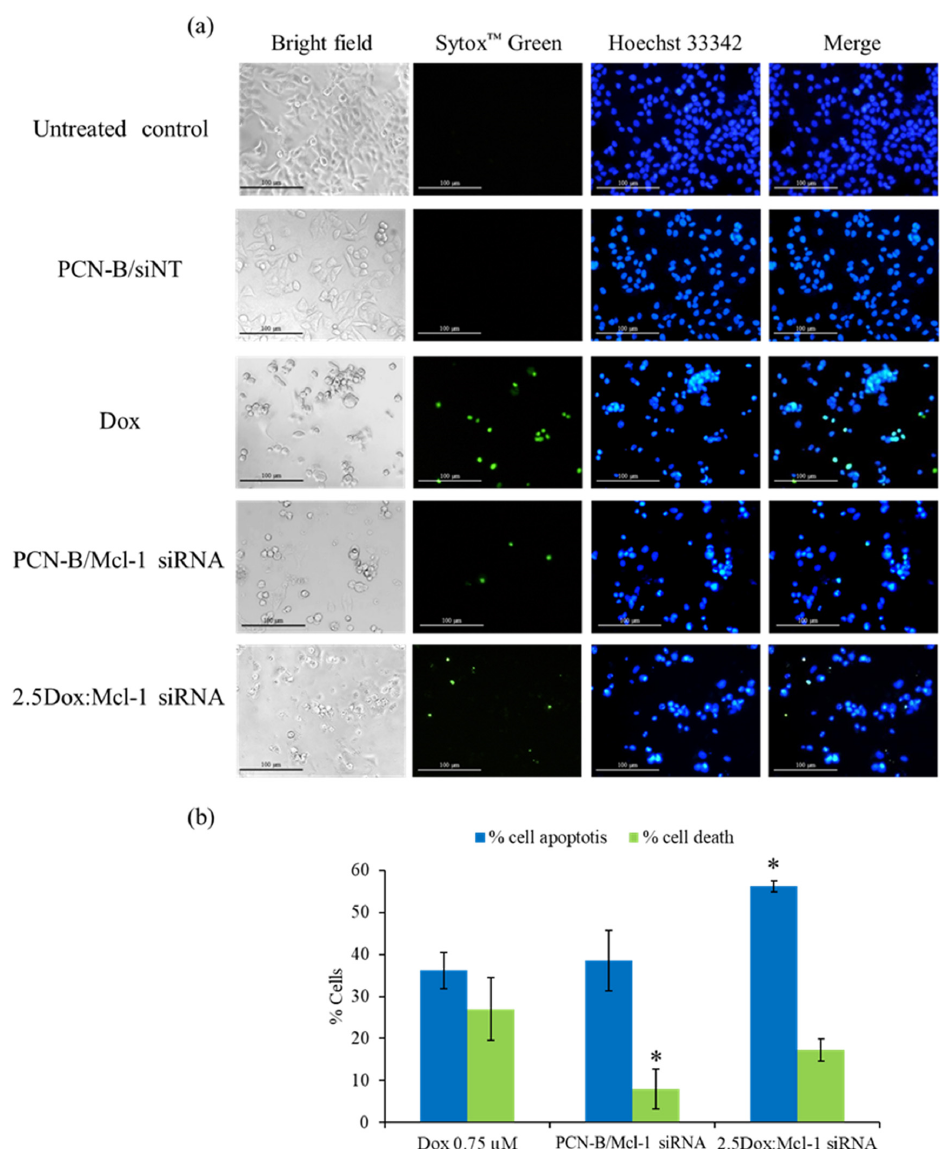
Figure 8. Double-stain apoptosis detection was observed under an inverted fluorescence microscope (100X) ( a ) after 24 h of treatments; untreated control, PCN-B/siNT, Dox (0.75 µM), Mcl-1 siRNA (0.1 µM), and the combination of Dox (0.25 µM) and Mcl-1 siRNA (0.1 µM) at the molar ratio of 2.5. Apoptotic and dead cells were counted and compared to all cells in the same area, presenting as % cell apoptosis (blue fluorescent cells) and cell death (green fluorescent cells) ( b ). * The data was signifi- cantly different from the Dox treatment at p -value <